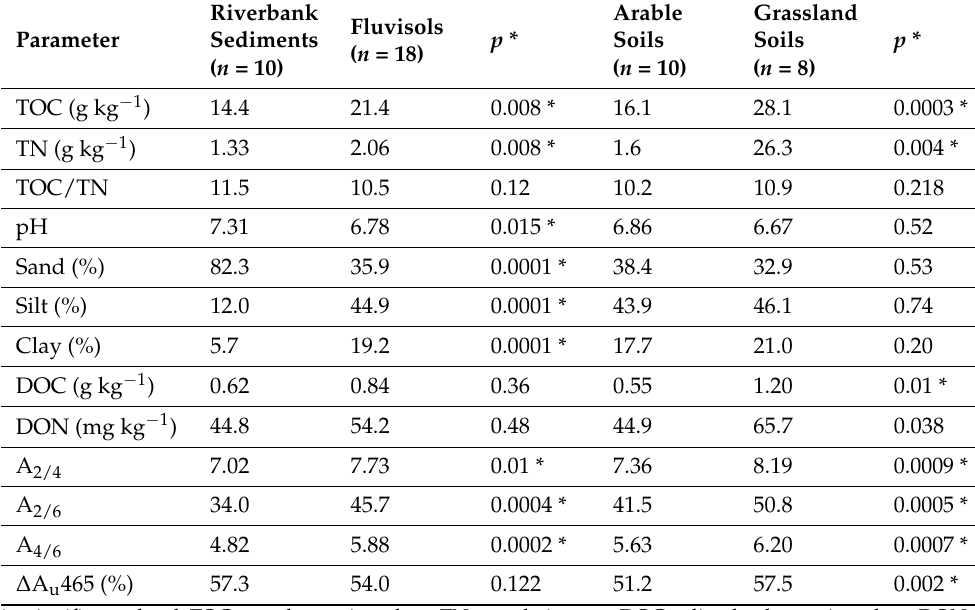
Table 1. The analysis of variance (ANOVA) with Tukey